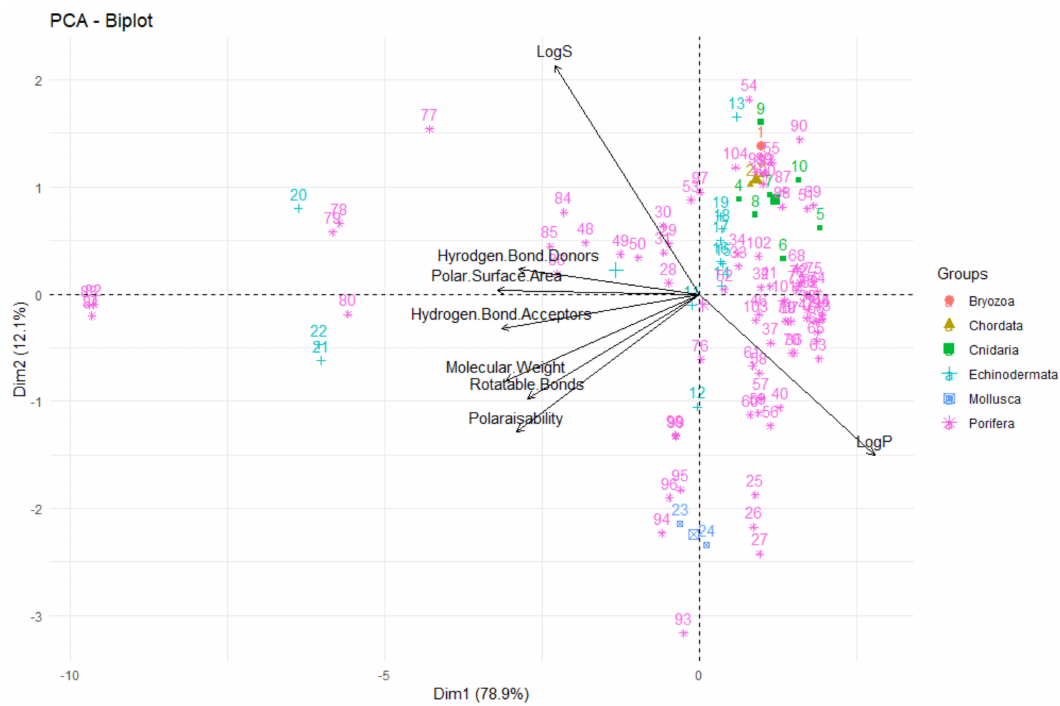
Figure 18. Biplot representing the PCA analysis on the compounds isolated from organisms in the Animalia Kingdom and their molecular descriptors (PC1 vs. PC2). The arrows represent molecular descriptors and the direction in which they hold influence. Each point represents a molecule.